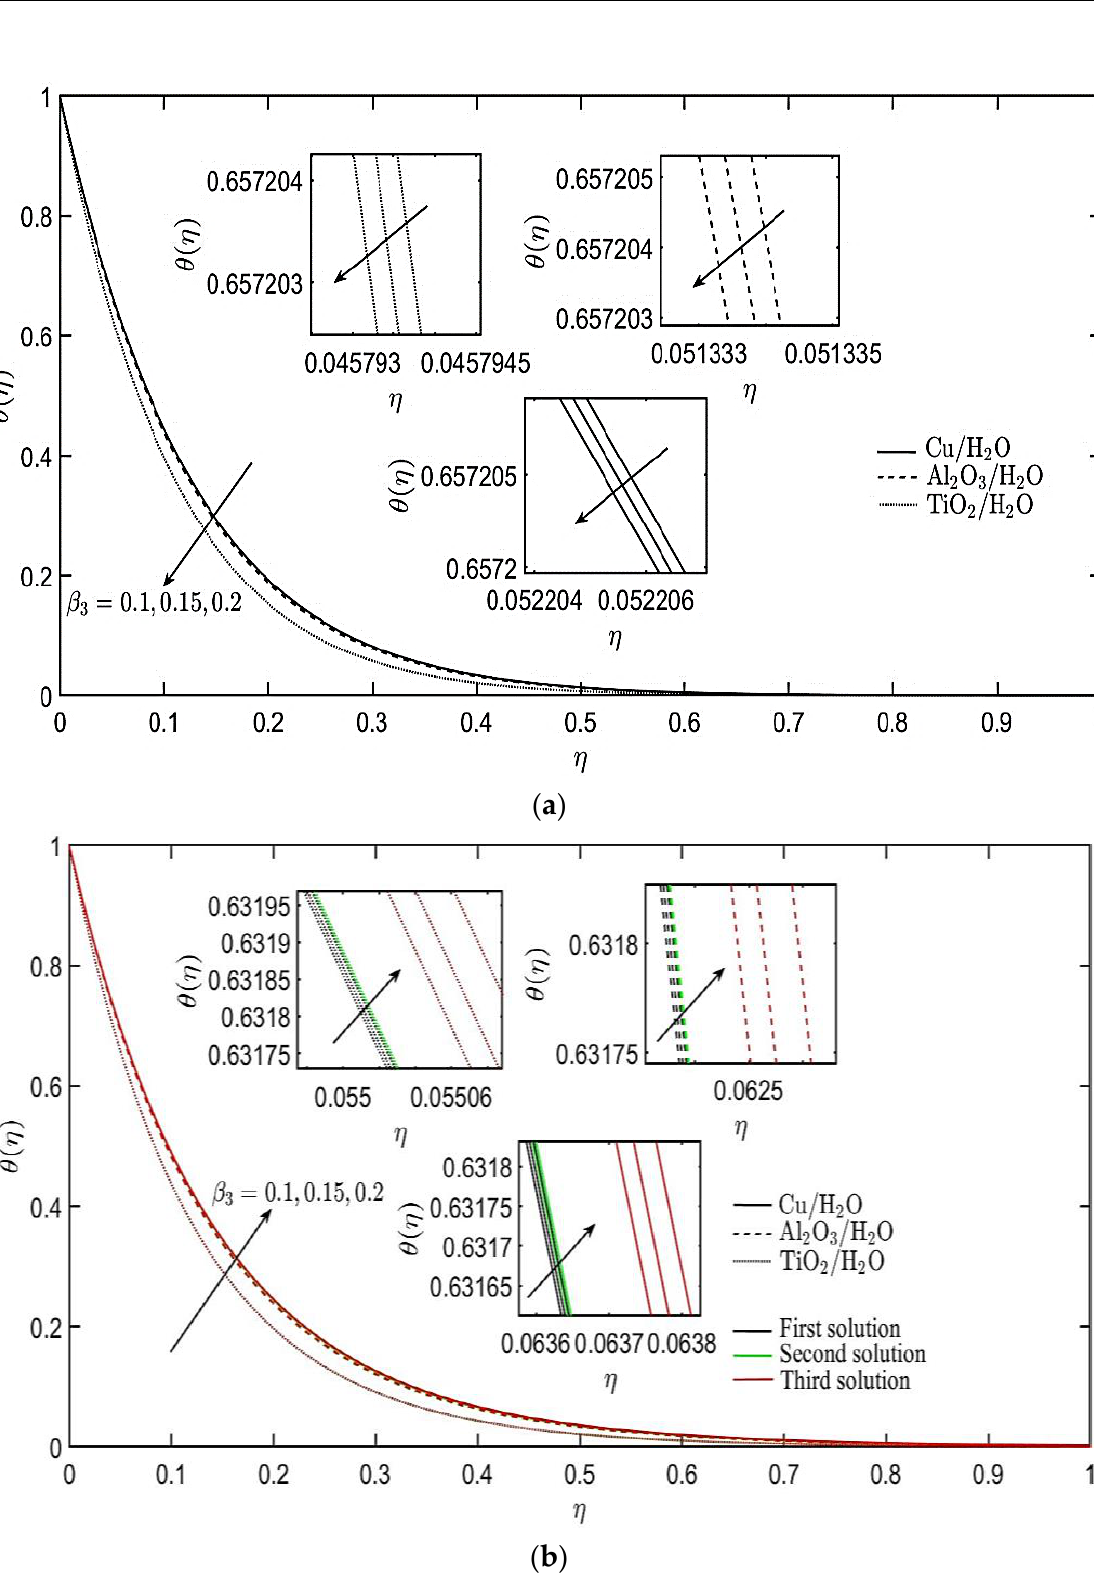
Figure 12. Effect of fluid retardation time parameter on temperature profiles for: ( a ) Stretching case; ( b ) Shrinking case.